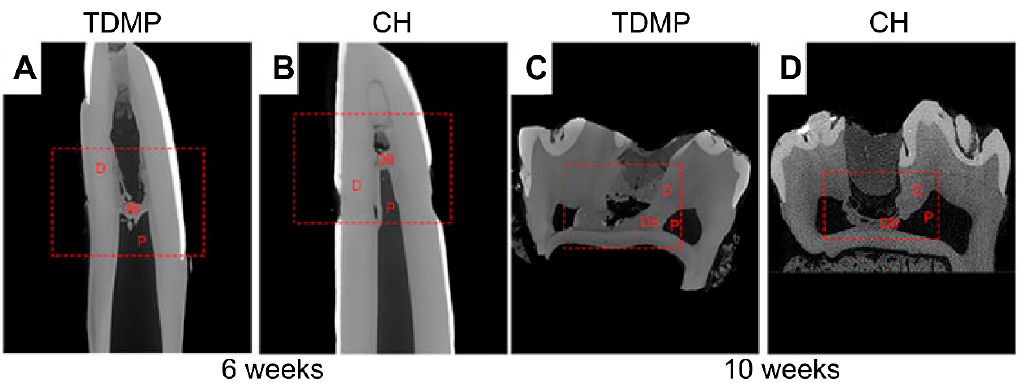
Figure 3. In vivo pulp-capping effects after pulp exposure. ( A – C ) Pulp exposure model in swine. ( A ) Perforation was created. ( B ) direct pulp-capping material was used. ( C ) The hole was sealed with glass ionomer. ( D ) Dentin bridge formation was analyzed by Micro-CT. (From Chen [10] J Tissue Eng Regen Med , with